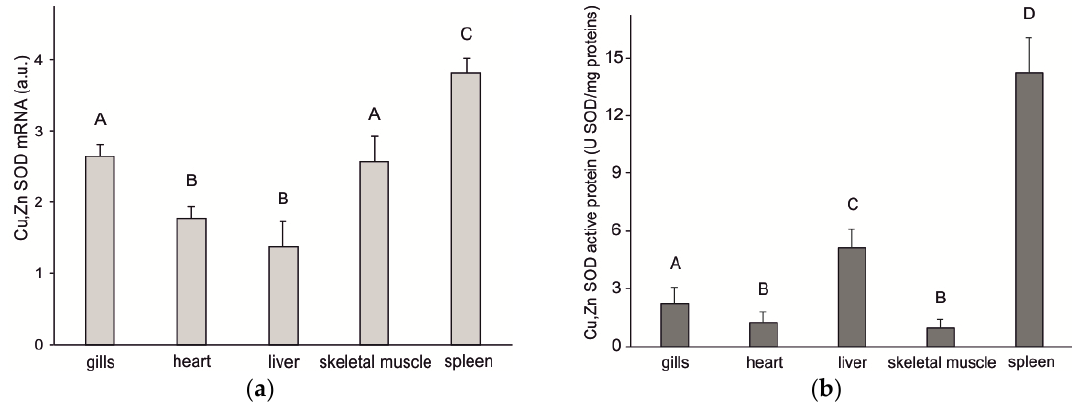
Figure 3. Levels in gills, heart, liver, spleen, and skeletal muscle of C. hamatus . ( a ) mRNA; ( b ) active protein. Meanswithdi ff erentletters(A–D)aresignificantlydi ff erentat p < 0.05(Student–Newman–Keuls t